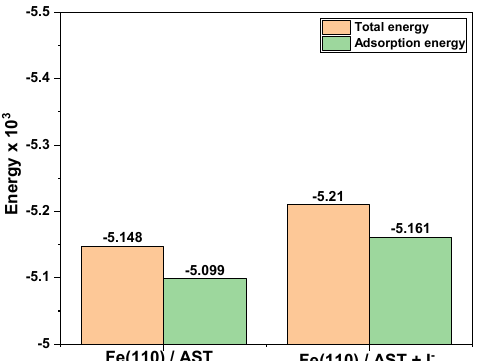
Figure 11. Total energy and adsorption energy calculated by the Mont Carlo simulation for the lowest adsorption configurations of AST and AST + I − systems on Fe (110)/400 H2O Interface at 25°C.